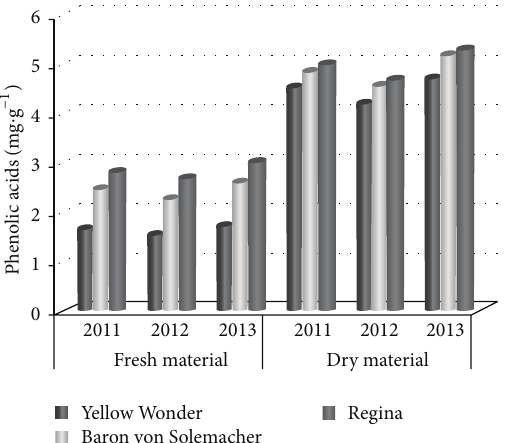
Figure 3: Content of tannins (%) in raw material in successive years of the study.